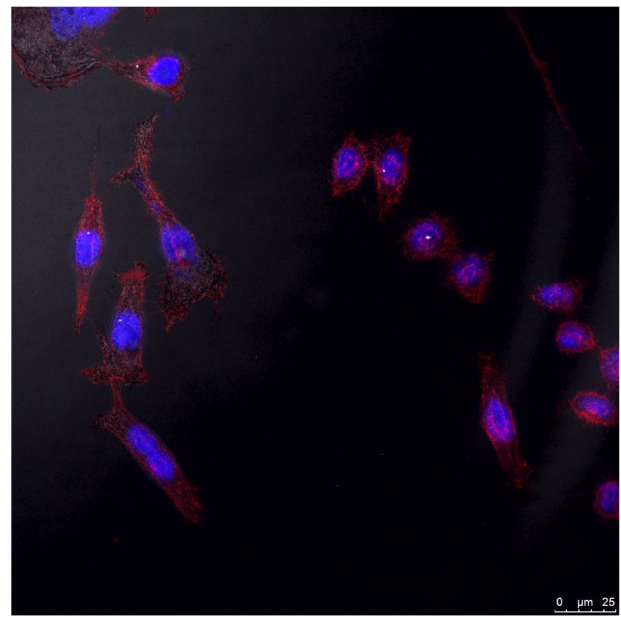
Figure 9. Confocal microscopy image in reflection mode of HeLa cells upon exposure to the MPA-capped CdTeSe QDs. Stained in blue and red are the cell nucleus and cytoplasm, respectively. QDs are observed in reflection mode as black dots all over the